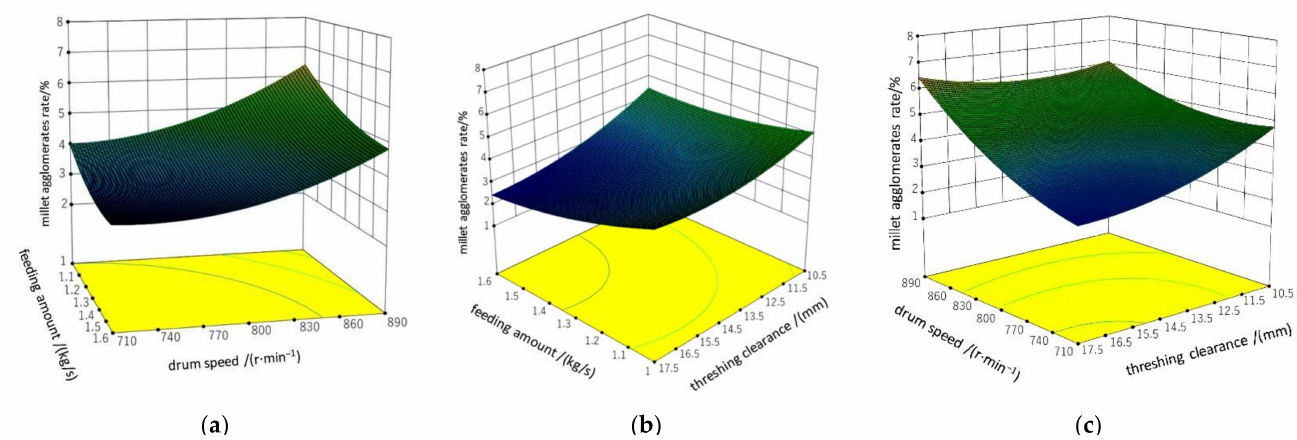
Figure 11. Influence of drum speed, feeding amount, and threshing clearance on millet agglomerates rate. ( a ) the picture shows the influence of drum speed and feeding amount on millet agglom- erates rate; ( b ) the picture shows the effect of threshing clearance and feeding amount on millet agglomerates rate; ( c ) the picture shows the effect of threshing clearance and drum speed on millet agglomerates